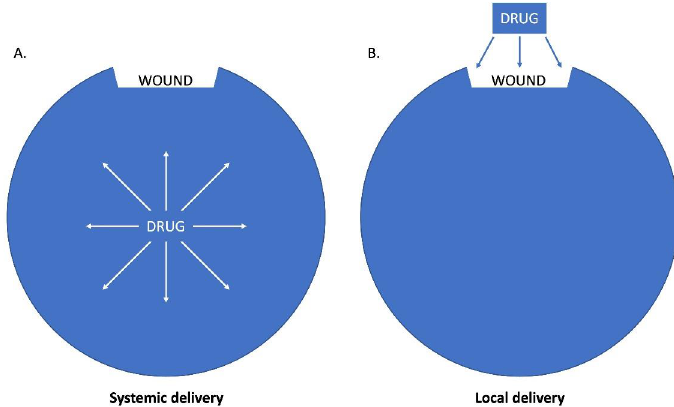
Figure 1. ( A ) Systemic drug delivery. The image depicts how the drug is diluted in the total body volume when delivered systemically (intravenously or orally). ( B ) Topical drug delivery. The image depicts how direct topical administration of the drug increases the effective concentration at the target site compared to systemic administration. The concentration is the highest at the surface of the wound, where it is needed the